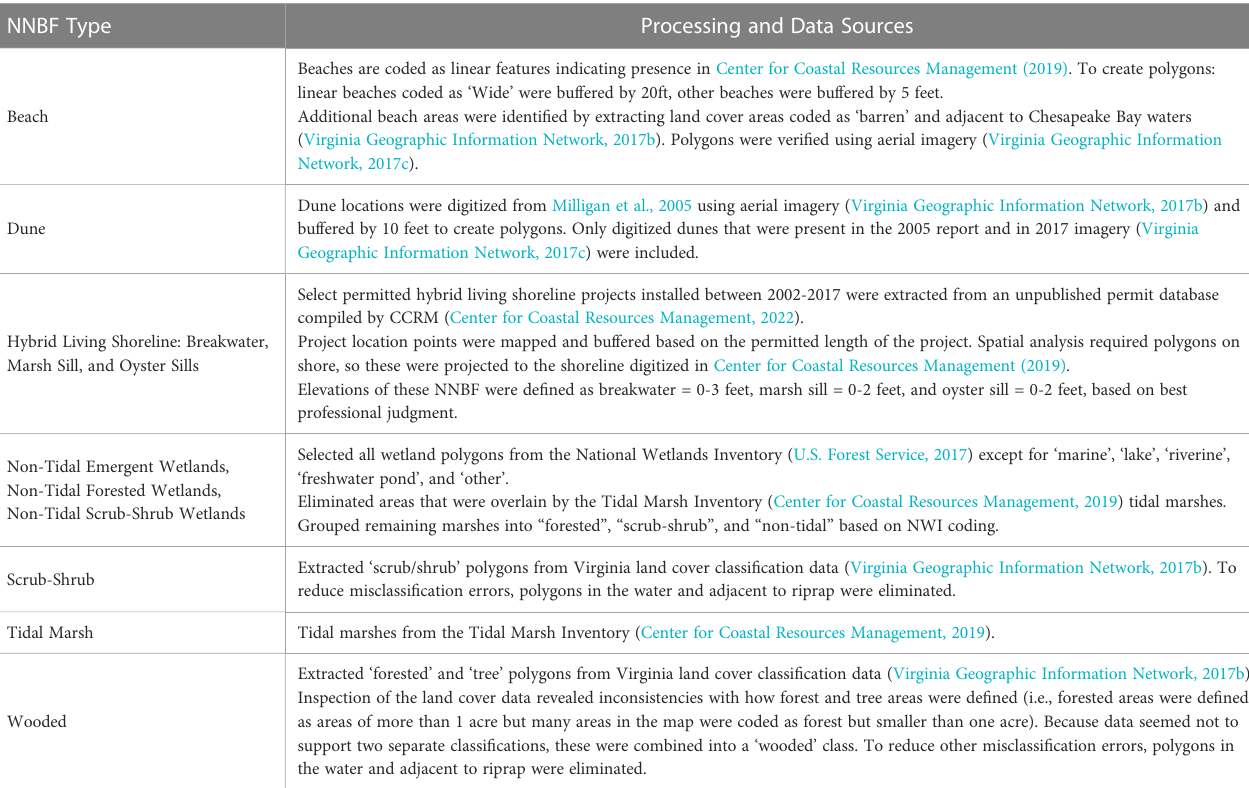
TABLE 1 List of sources and processing steps used to create an inventory of NNBF across the study area. NNBF Type